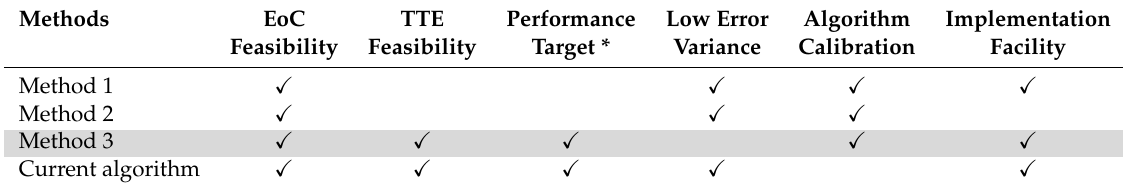
Table 2. Comparison between the proposed methods; ∗ = the target for performance refers to the EoC estimation error, i.e., the error between the moisture reference and the estimate. The target formalized is to remain under a certain value of the error quantified using the RMSE metric defined before.